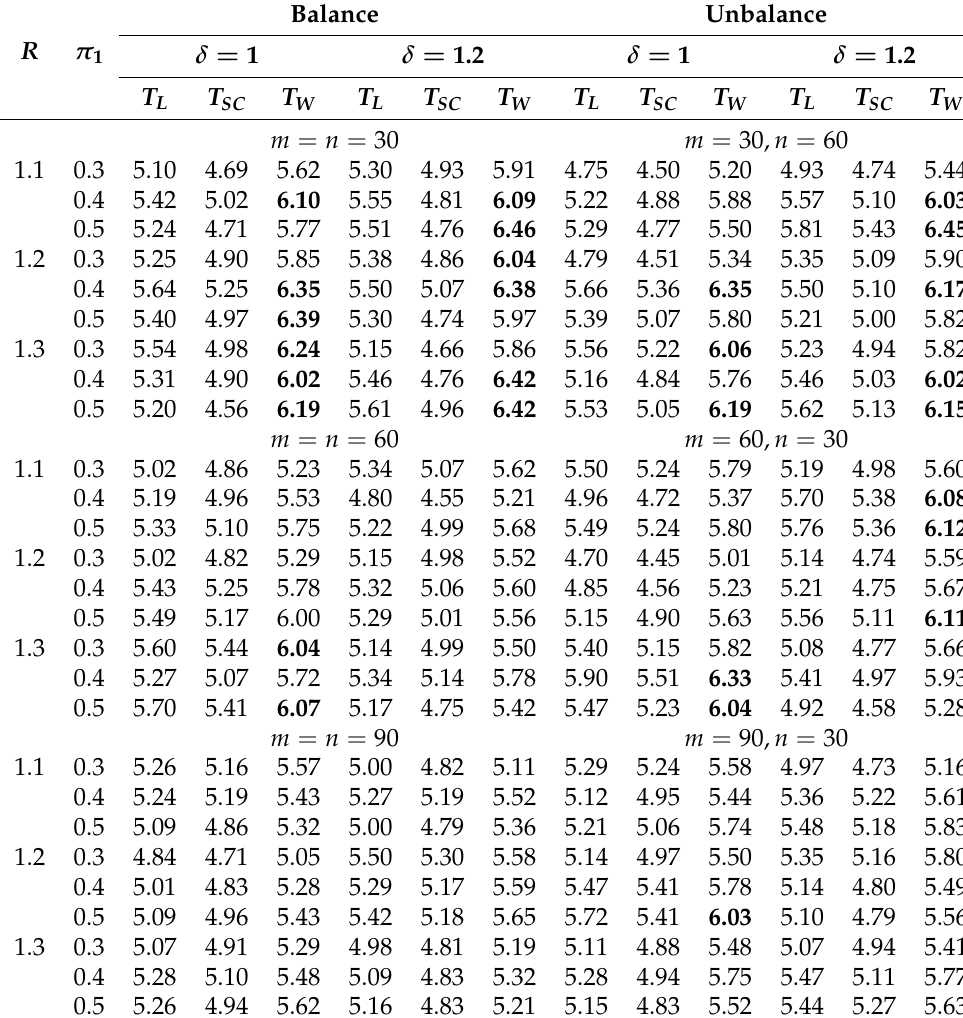
Table 4. The empirical TIEs (%) of tests under H 0 : δ i = δ ( g = 4, α = 0.05). Balance R π 1